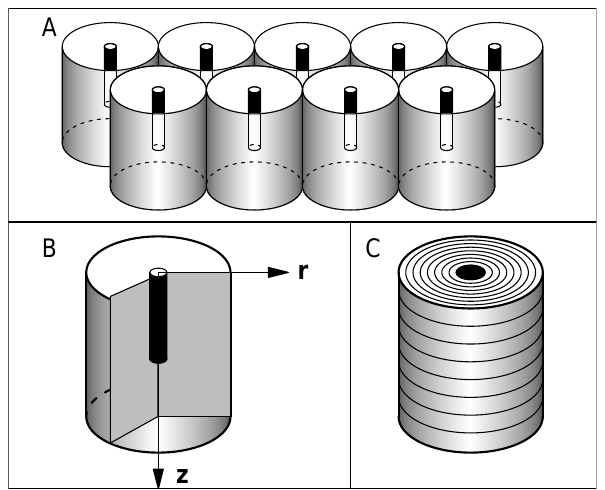
Fig. 2. (A) Schematic representation of the sediment, consisting of a set of cylindrical tubes, with the worm in the centre (black). (B) Only one cylinder is modeled in a 2-D setting, along a radial axis ( r ) and a depth axis ( z ). (C) The numerical discretisation subdivides the cylinder in a stack of